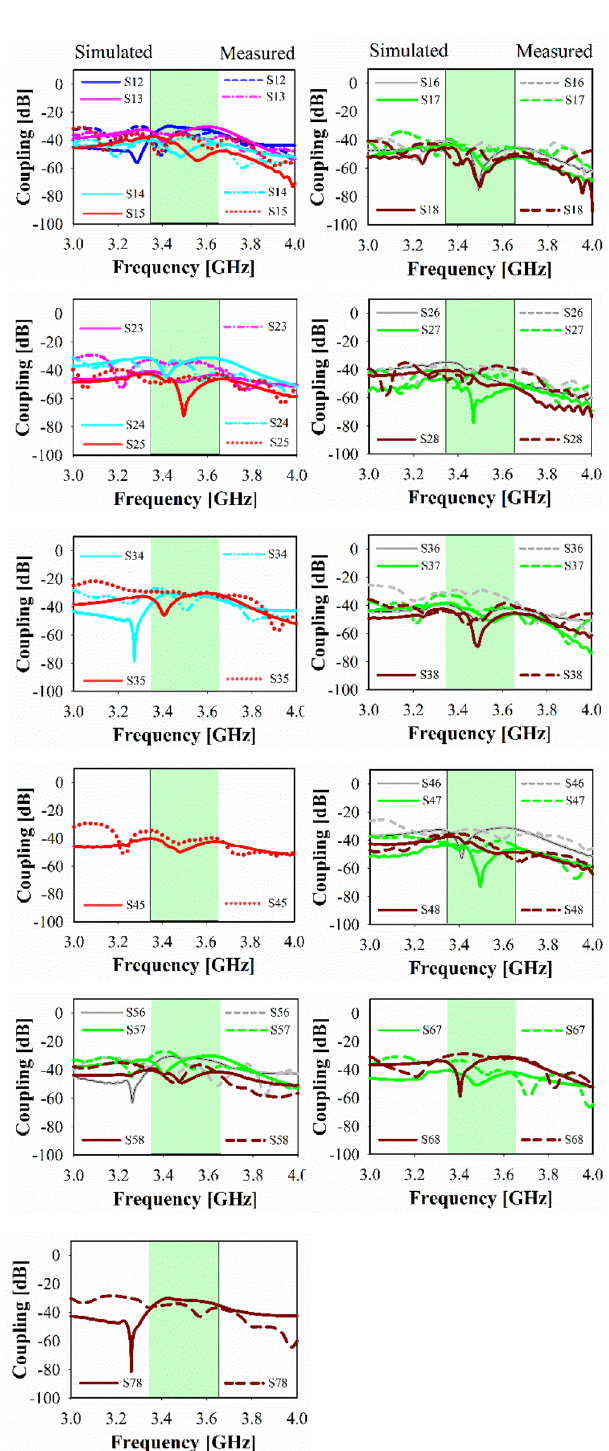
Figure 14. Simulated and measured coupling between each adjacent